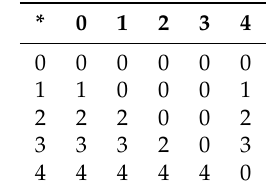
Table 7. Cayley table for the binary operation